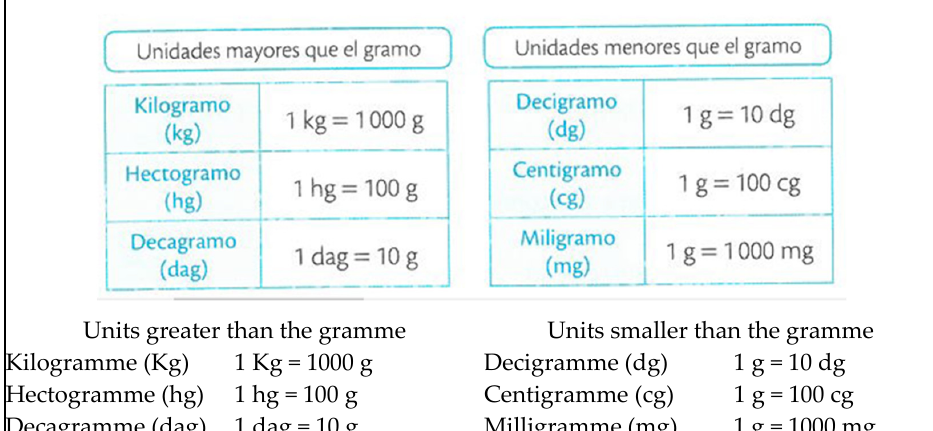
Figure 5. Equivalence between units of measure (fifth year mathematics, SM [45]).